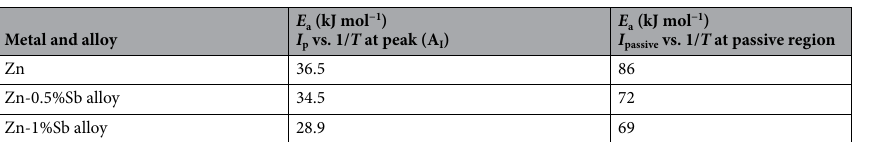
Metal and alloy